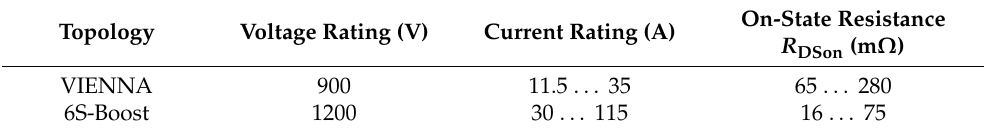
Table 2. Characteristics of SiC MOSFETs used for